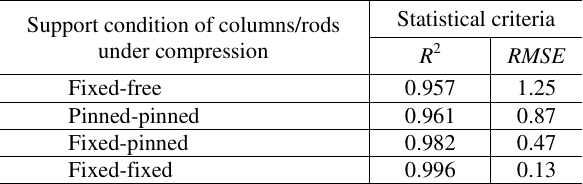
Table 3. Comparison of performances of the models used based on statistical criteria in the critical buckling load esti-